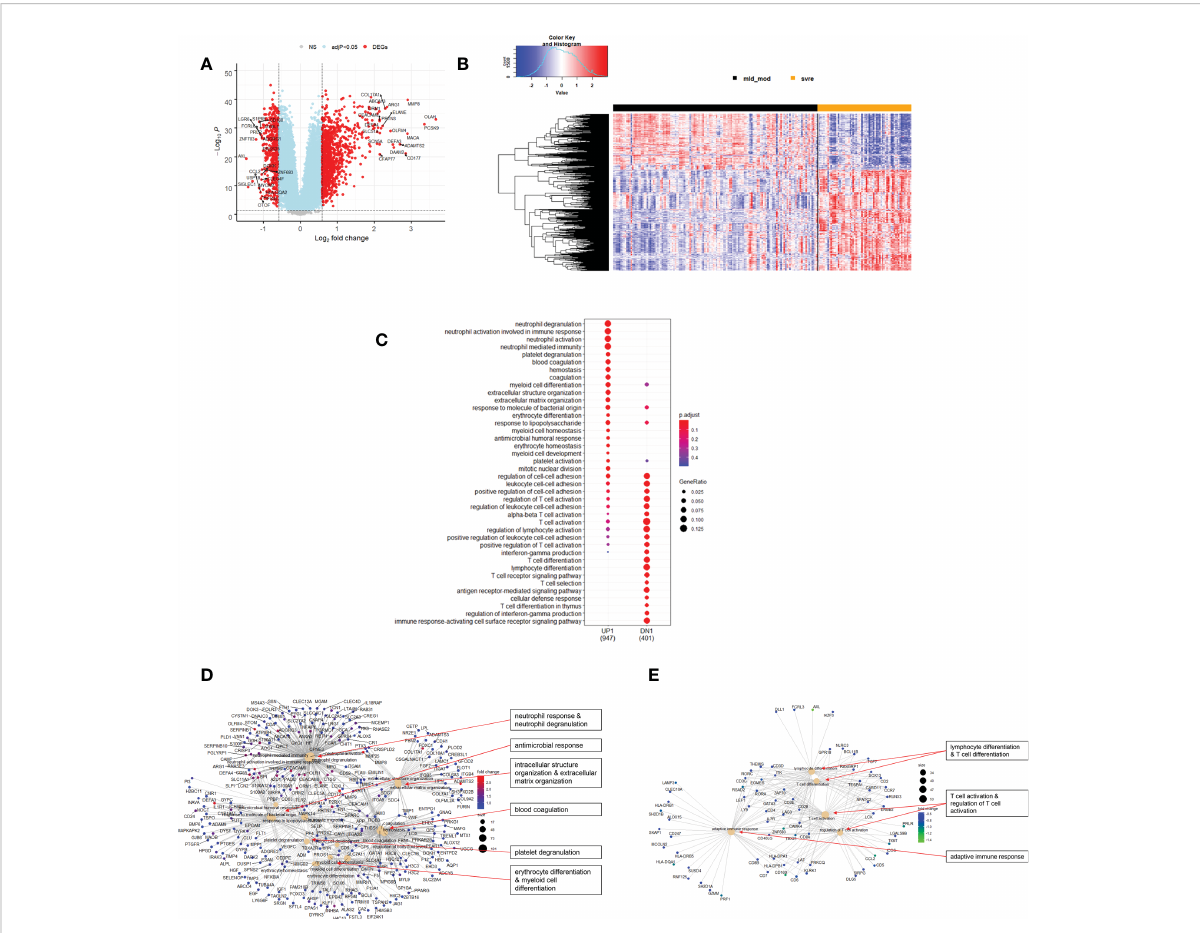
FIGURE 8 Differential genes expression analysis contrasting mild/moderate to severe cases. (A) Volcano plot of results of the contrast from the linear regression analysis. Y-axis: -log 10 BH multiple testing adjusted p-values, x-axis: log 2 fold change. DEGs (absolute log-fold change > 1.5, corresponding to a log 2 -fold change > 0.58; multiple testing adjusted p-value < 0.05) are colored red and the top 20 up- and down-regulated (by log-fold change) DEGs are labeled. Blue: genes with adjusted p-value < 0.05. (B) Heatmap of expression levels of top 500 (by log fold change) regulated DEGs. Values were scaled by row. Red: up-regulated DEGs, blue: down-regulated DEGS. HC: healthy controls, mld/mod: mild/moderate pateints. (C) Functional analysis using GO term enrichment for up- and down-regulated DEGs showing 20 most signi fi cant pathway annotations for both groups. (D) cnetplot illustrating relationship of up-regulated DEGs to pathway annotations. (E) cnetplot illustrating relationship of down-regulated DEGs to pathway annotations. Nodes in cnetplots represent pathways signi fi cantly associated with the differentially expressed genes. The differentially expressed genes are connected to these nodes with color-coded log-fold changes from